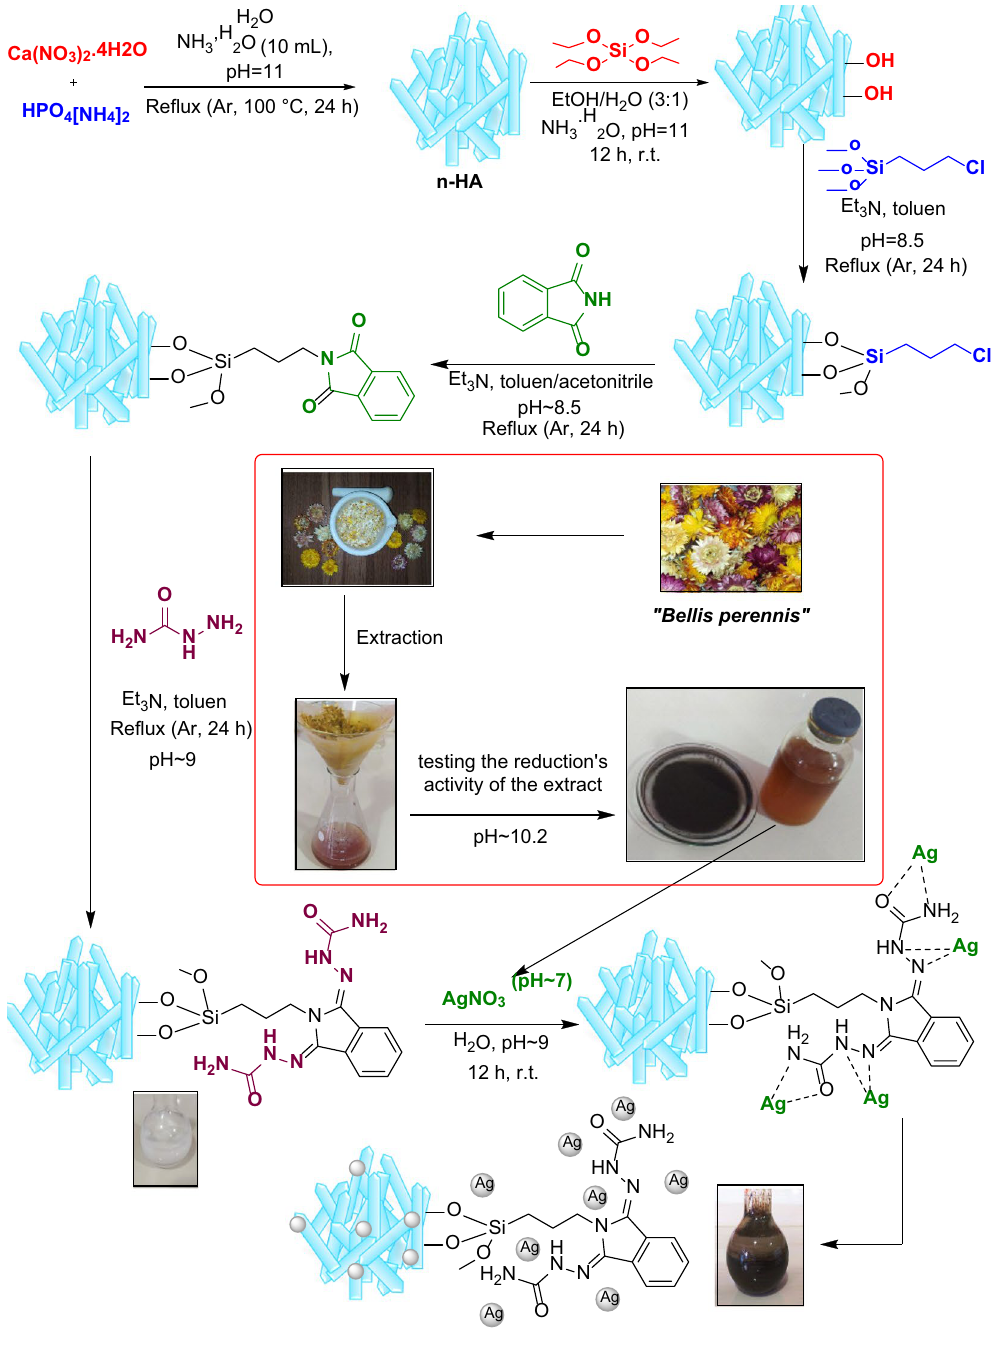
Figure 6. The synthetic process of